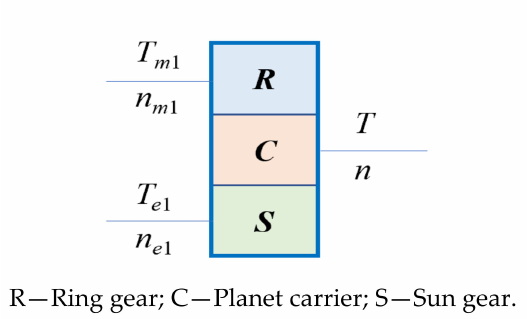
Figure 7. Schematic diagram of speed coupling system (single planetary gear